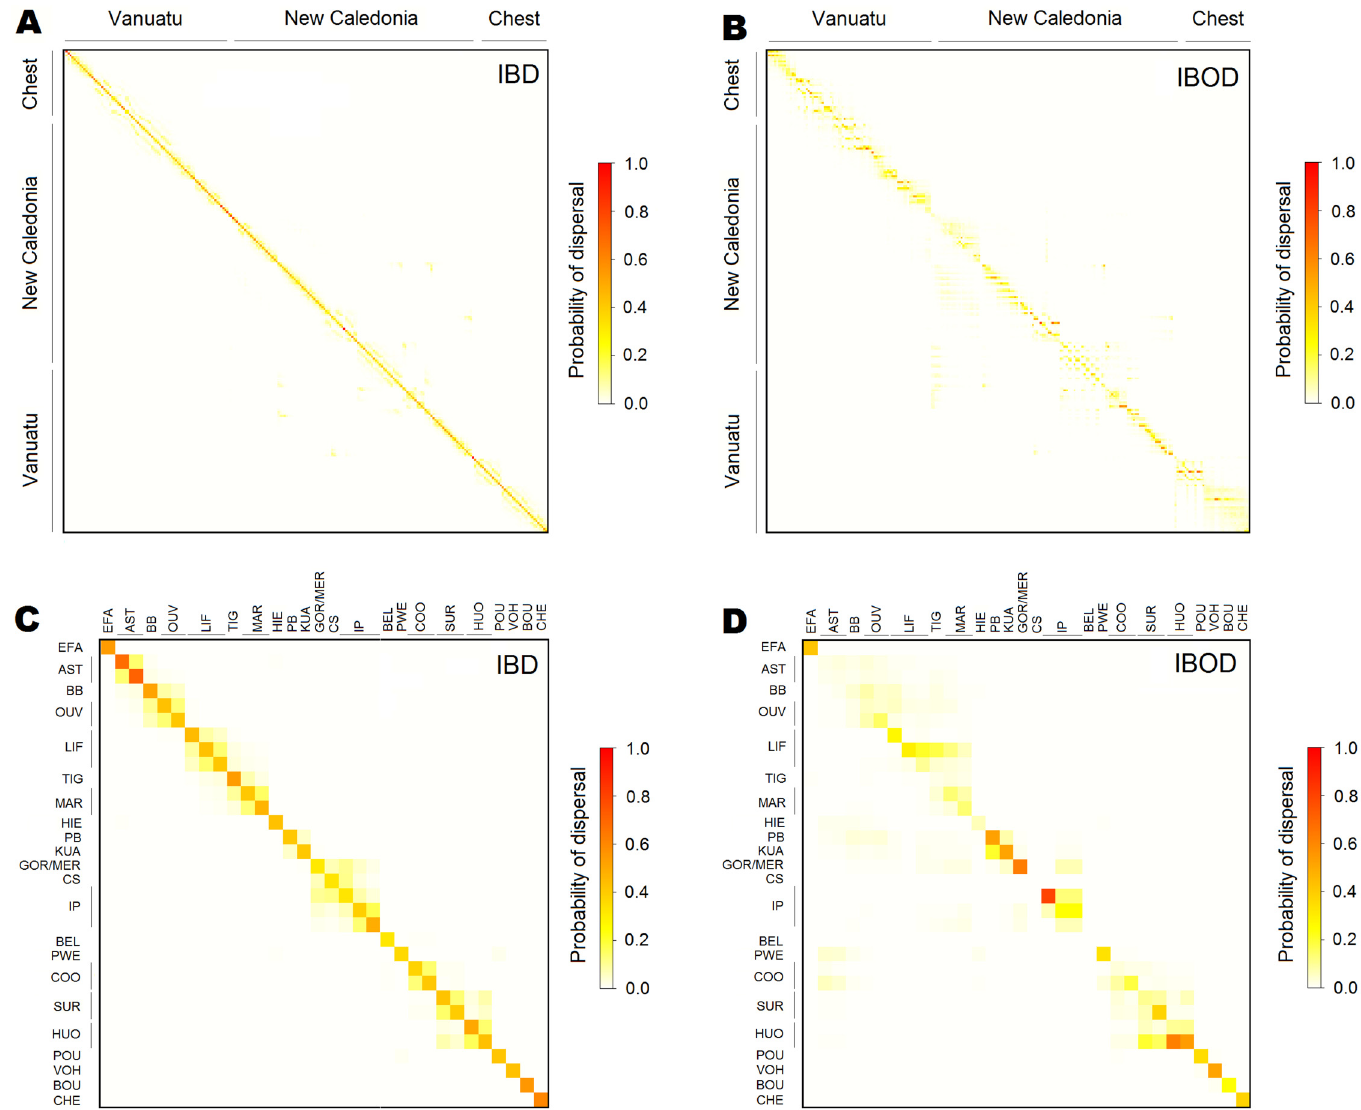
Fig 4. Connectivity matricesbetween all habitat patches considering an IBD dispersal kernel (A and C) or an IBOD dispersal kernel (B and D). A) and B) displayall habitat patches (see Fig 3D), while C) and D) only displayhabitat patches that were sampledfor geneticanalyses(see Fig